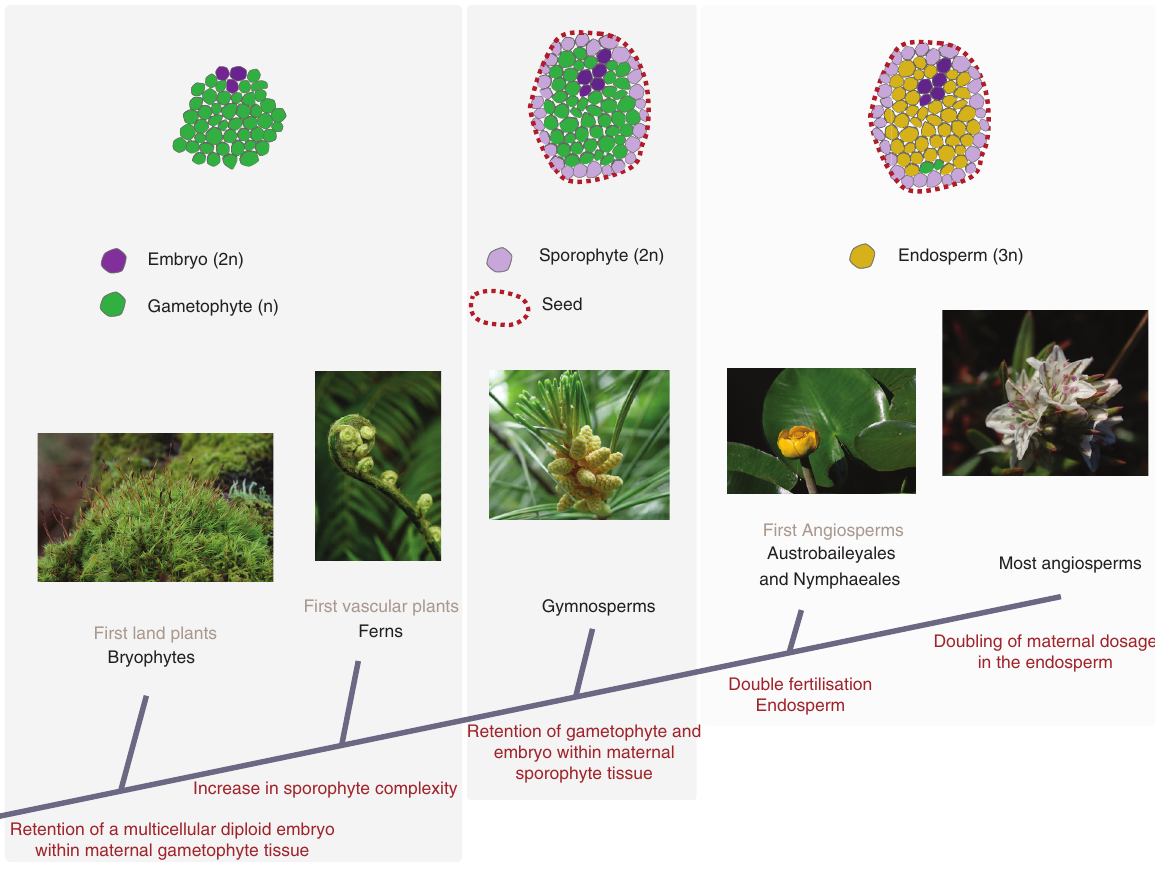
Figure 1 Progressive retention of the diploid embryo within parental tissues during land plant